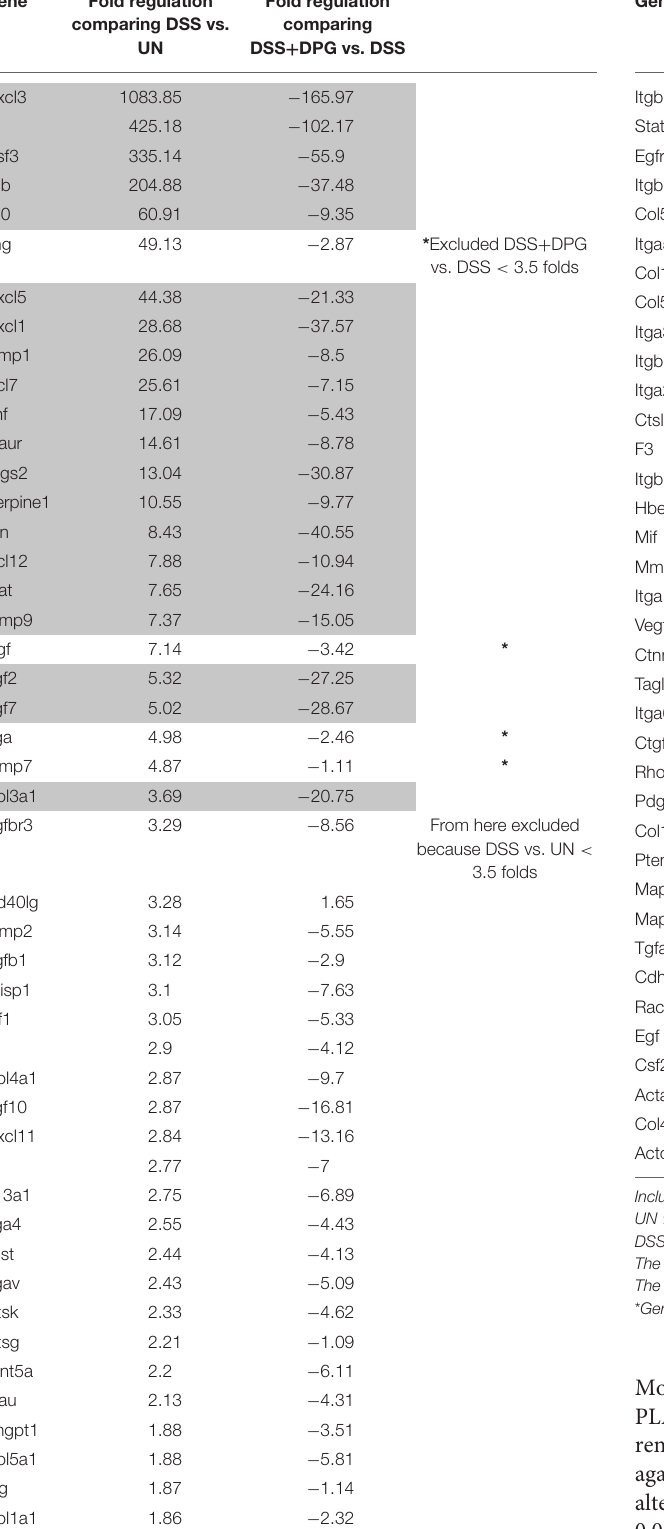
Fold regulation comparing DSS